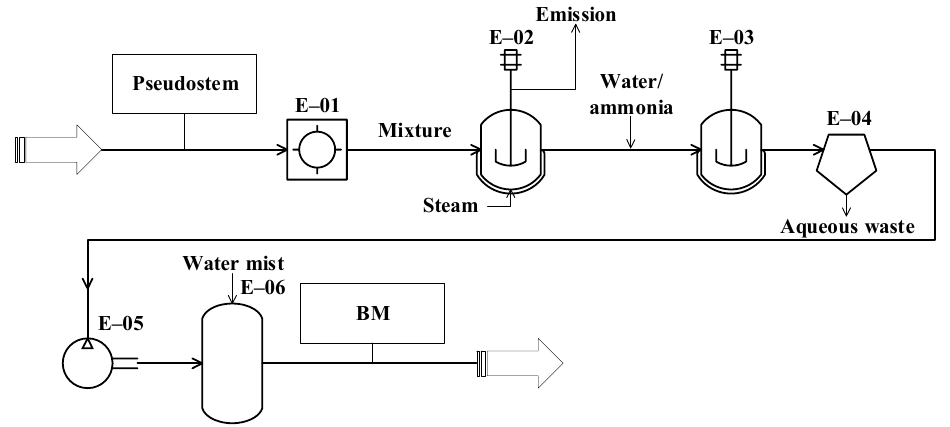
Figure 3. Diagram of the conceptual design for biomethane (BM) production from plantain pseu- dostems.